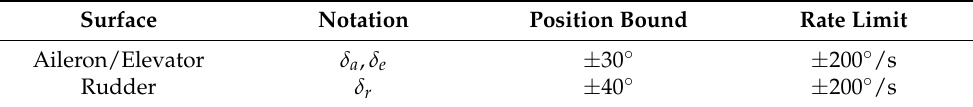
Table 2. Deflection range of the surfaces on the tailless aircraft